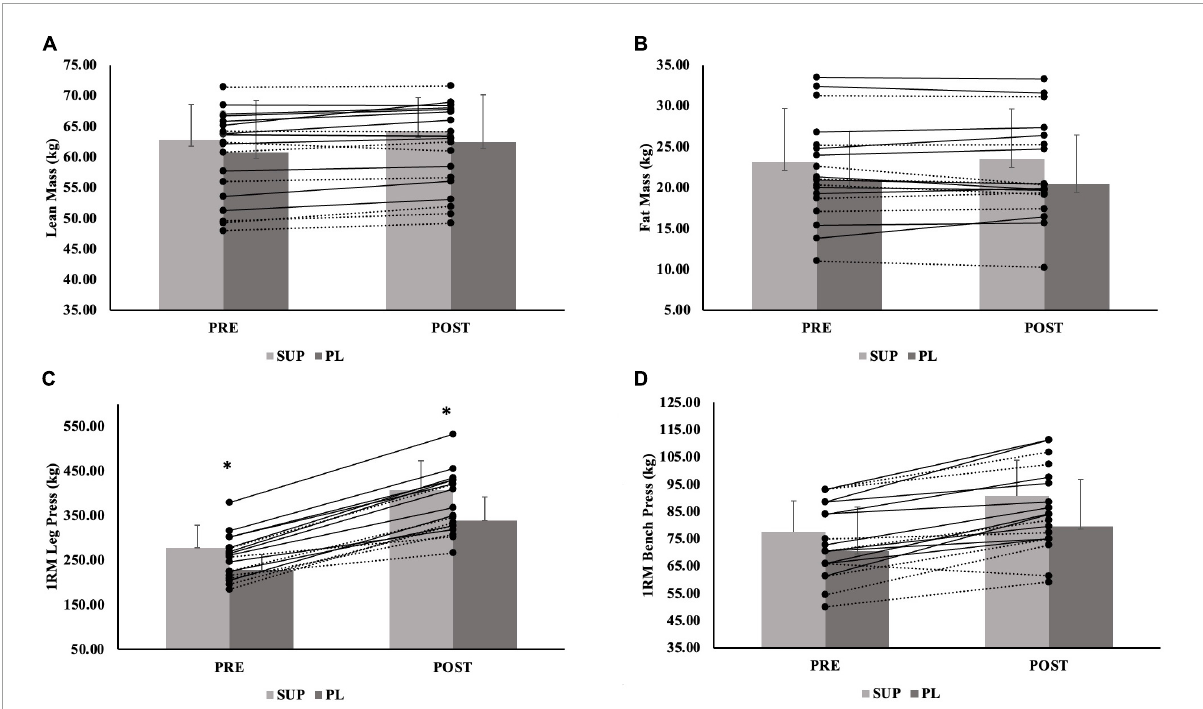
FIGURE3 (A–D) Male individual responses for (A) lean mass, (B) fat mass, and (C) 1RM leg press, and (D) 1RM Bench Press. The lines represent the differences between baseline (PRE) and post-testing visit (POST) per participant. The solid lines represent males in the supplement group ( n = 10). The dashed lines represent males in the PL group ( n = 8). The gray bars represent treatment means for the supplement (SUP; light gray) and placebo (PL; dark gray) groups with average standard deviation (error bars). ∗ Indicates significant main effect for group ( p = 0.002).